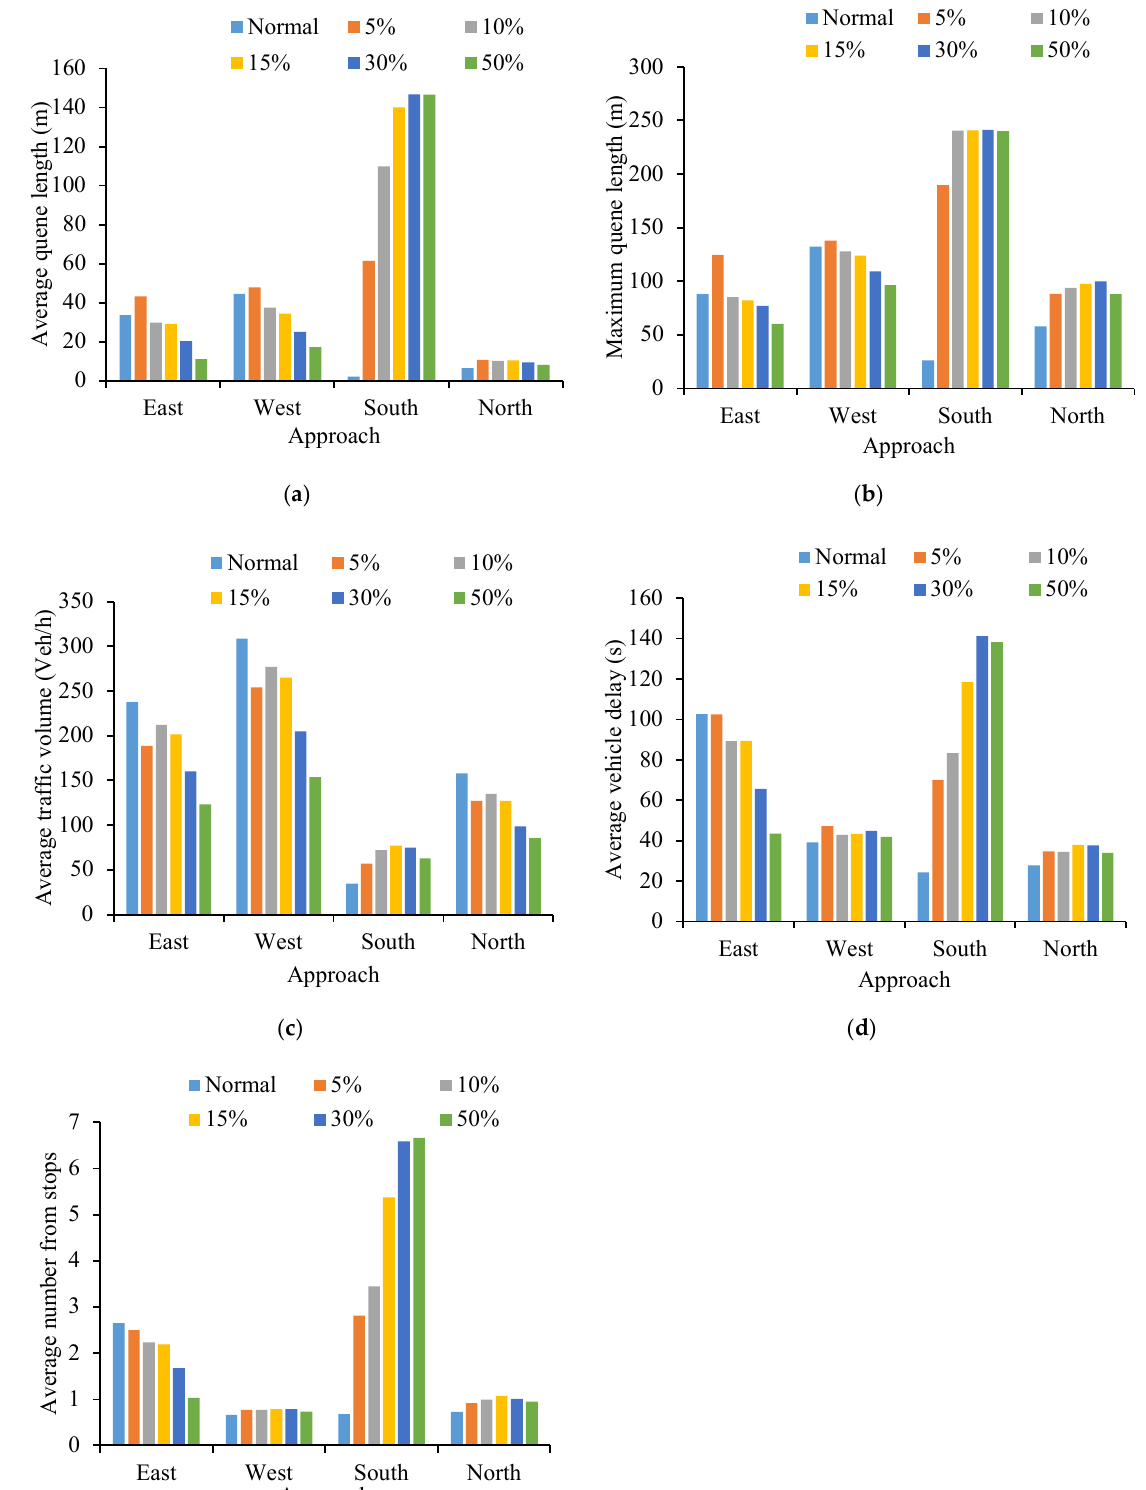
Figure 11. Phase timing diagram at No. 3 intersection.